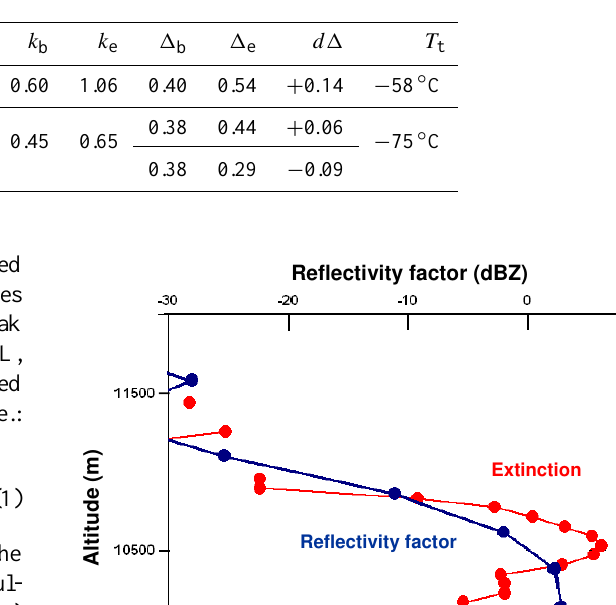
Table 1. Baseline and enhanced integrated attenuated backscatter values ( γ 0 backscatter-to-extinction ratio ( k b and k e ) for η = 0 . 6, baseline and enhanced (or reduced) of the integrated depolarisation ratios ( 1 b and